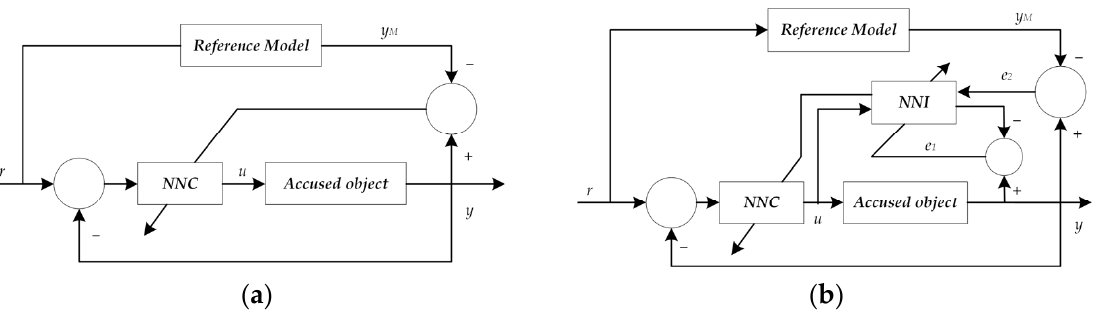
Figure 9. Model reference adaptive control schematic. (( a ) is directly adaptive; ( b ) is indirectly adap- tive).